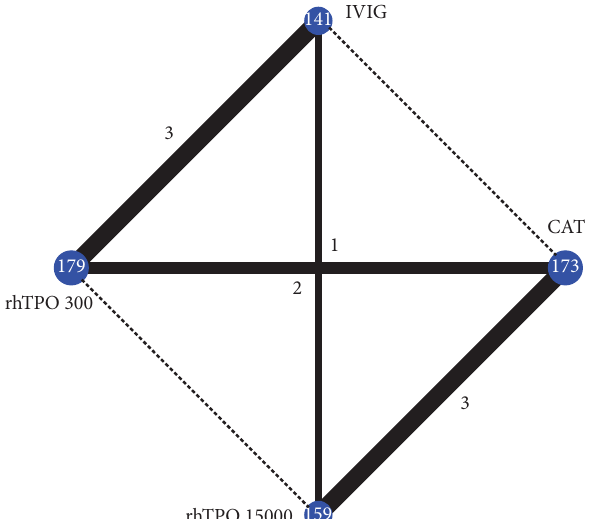
Figure 2: Evidence network of 28-day mortality. NAT, no additional treatment; IVIG, intravenous immunoglobulin; rhTPO 300, 300U/kg/ d recombinant human thrombopoietin; rhTPO 15000, 15000U/d recombinant human thrombopoietin.